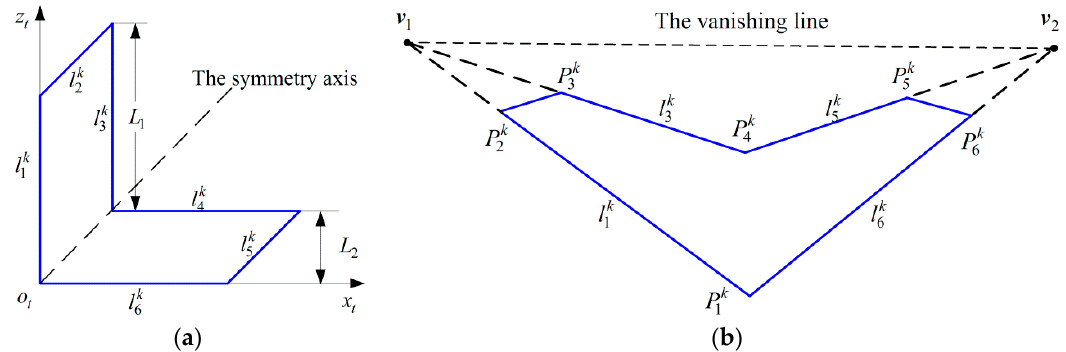
Figure 1. Planar target with two mutually orthogonal groups of parallel lines: ( a ) Planform of target k ; ( b ) Perspective projection of target k onto the image plane.